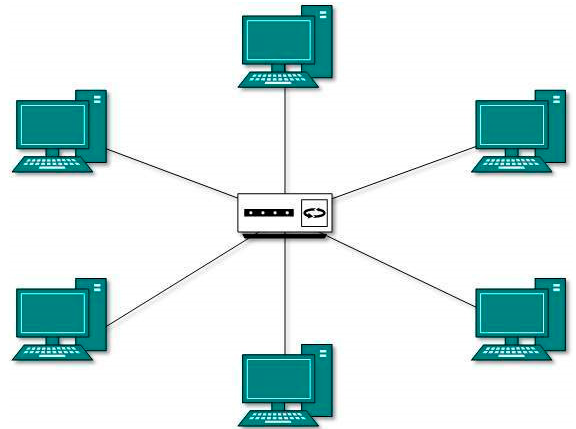
Figure 4. Star topology structure [24].